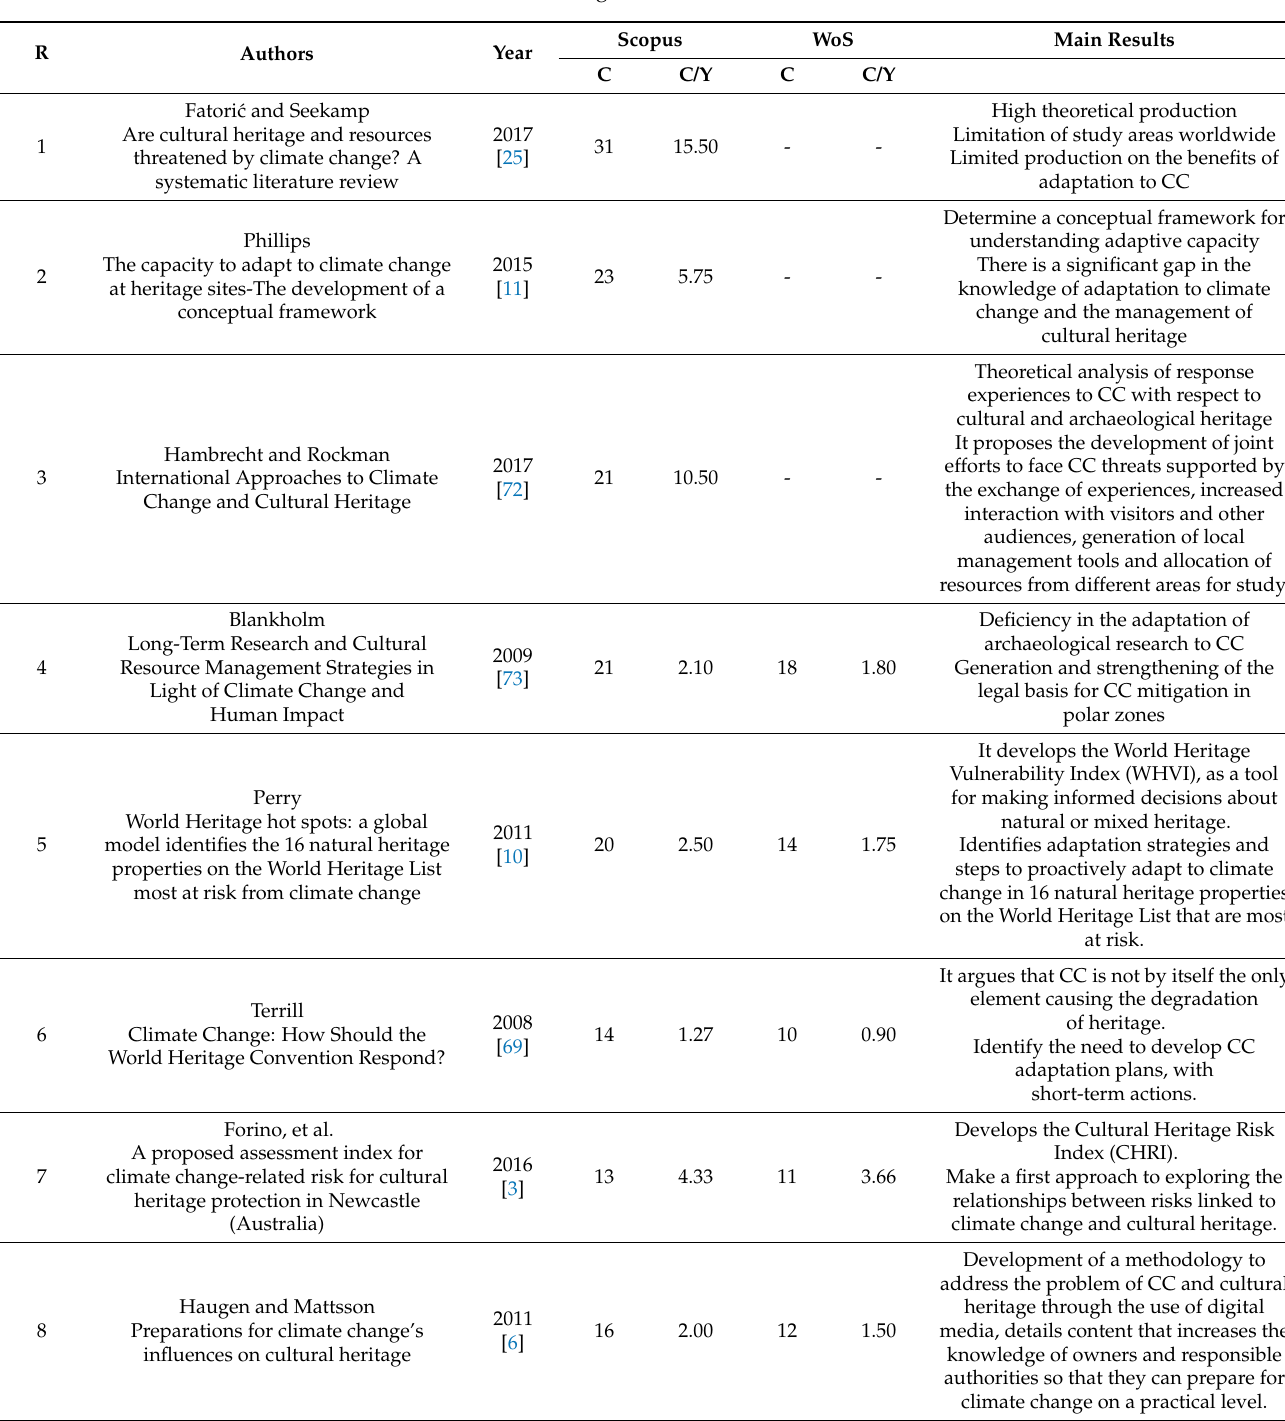
Table 3. Ranking of the most cited